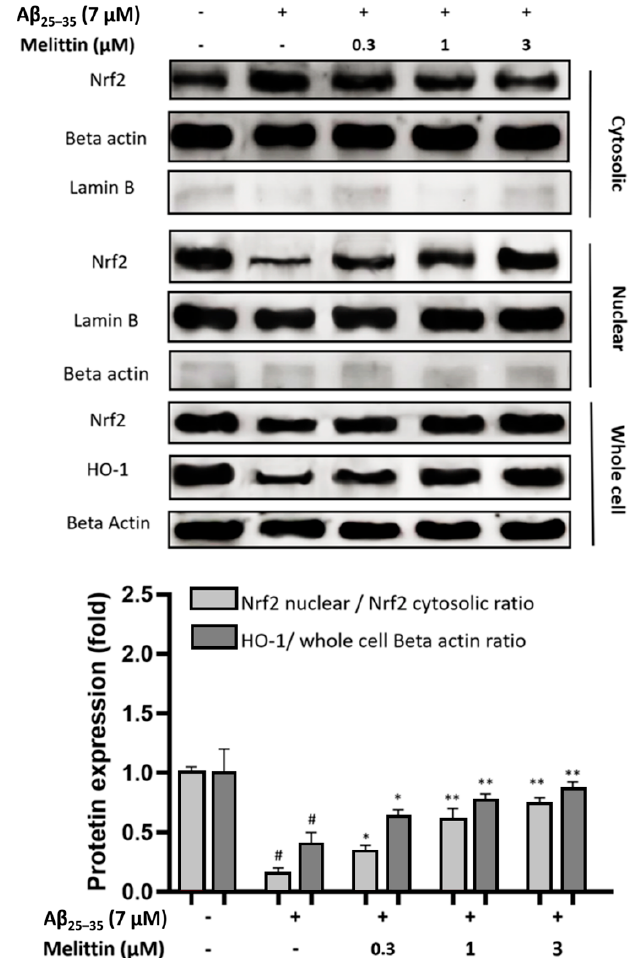
Figure 4. Effect of melittin on nuclear translocation of Nrf2 and an increase in the production of the antioxidant enzyme HO-1. The result suggested that melittin at 0.3 to 3 µ M dosage-dependently enhanced Nrf2 nuclear translocation and as a result increased the expression of the HO-1 antioxidant enzyme in HT22 cells under A β 25–35 (7 µ M) challenge. To conduct this experiment: Seven hours after A β 25–35 (7 µ M) challenge in 6-well plates, whole cell, cytosolic, and nuclear proteins were obtained, and western blot was conducted. The membranes of Nrf2, Lamin B, and Beta actin in cytosolic extract and the membranes of their respective counterparts in nuclear extract under similar treatments and imaging exposure time to express the true scale of protein expression between nuclear and cytosolic proteins. Total Lamin B signal of the cytosolic extract was less than 5% of that in the nuclear extract, total Beta actin in the cytosolic extract was less than 5% of that in the nuclear extract (numeric bars not shown); this indicates the reliability of the manual extraction conducted. Data are presented as mean ± standard deviation values of triple determinations. # p < 0.01 vs. Control * p < 0.05 and ** p < 0.01 vs. A β 25–35 only-treated group.